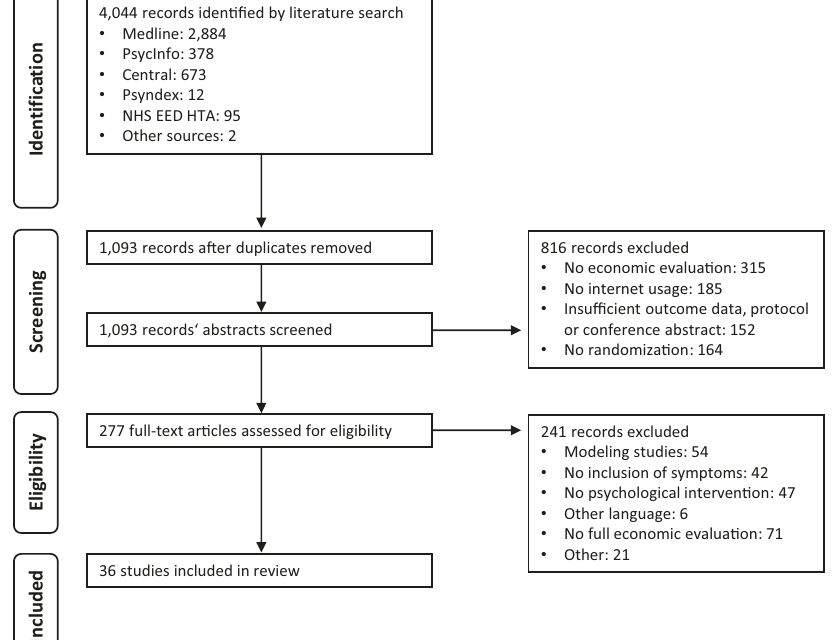
Fig. 1 PRISMA fl ow diagram. Using the Preferred Reporting Items for Systematic Reviews and Meta-Analyses as a screening process, a total of 36 studies were included in the